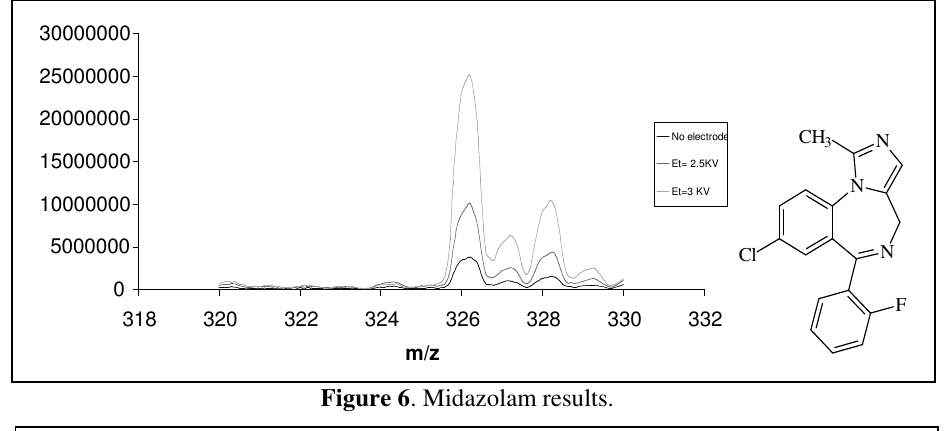
Figure 6 . Midazolam results.